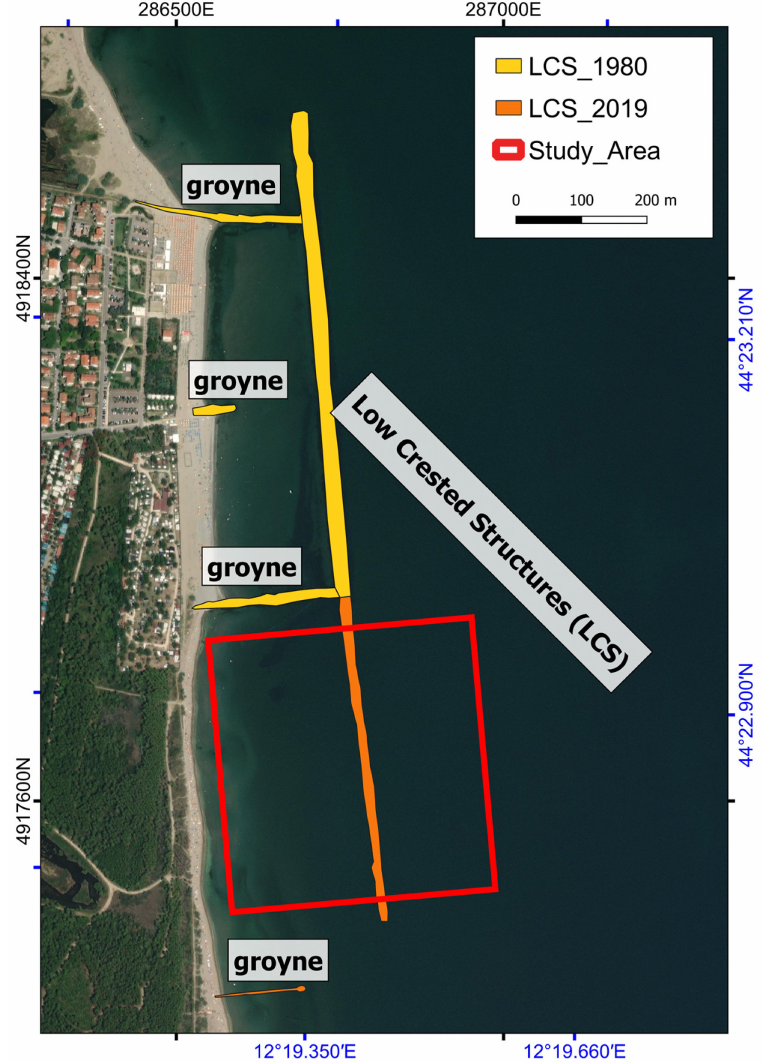
Figure 2. Shore protection structures in the Lido di Dante beach. Red lines delimit the study area (base map: Google Earth 3 April 2020; projection: